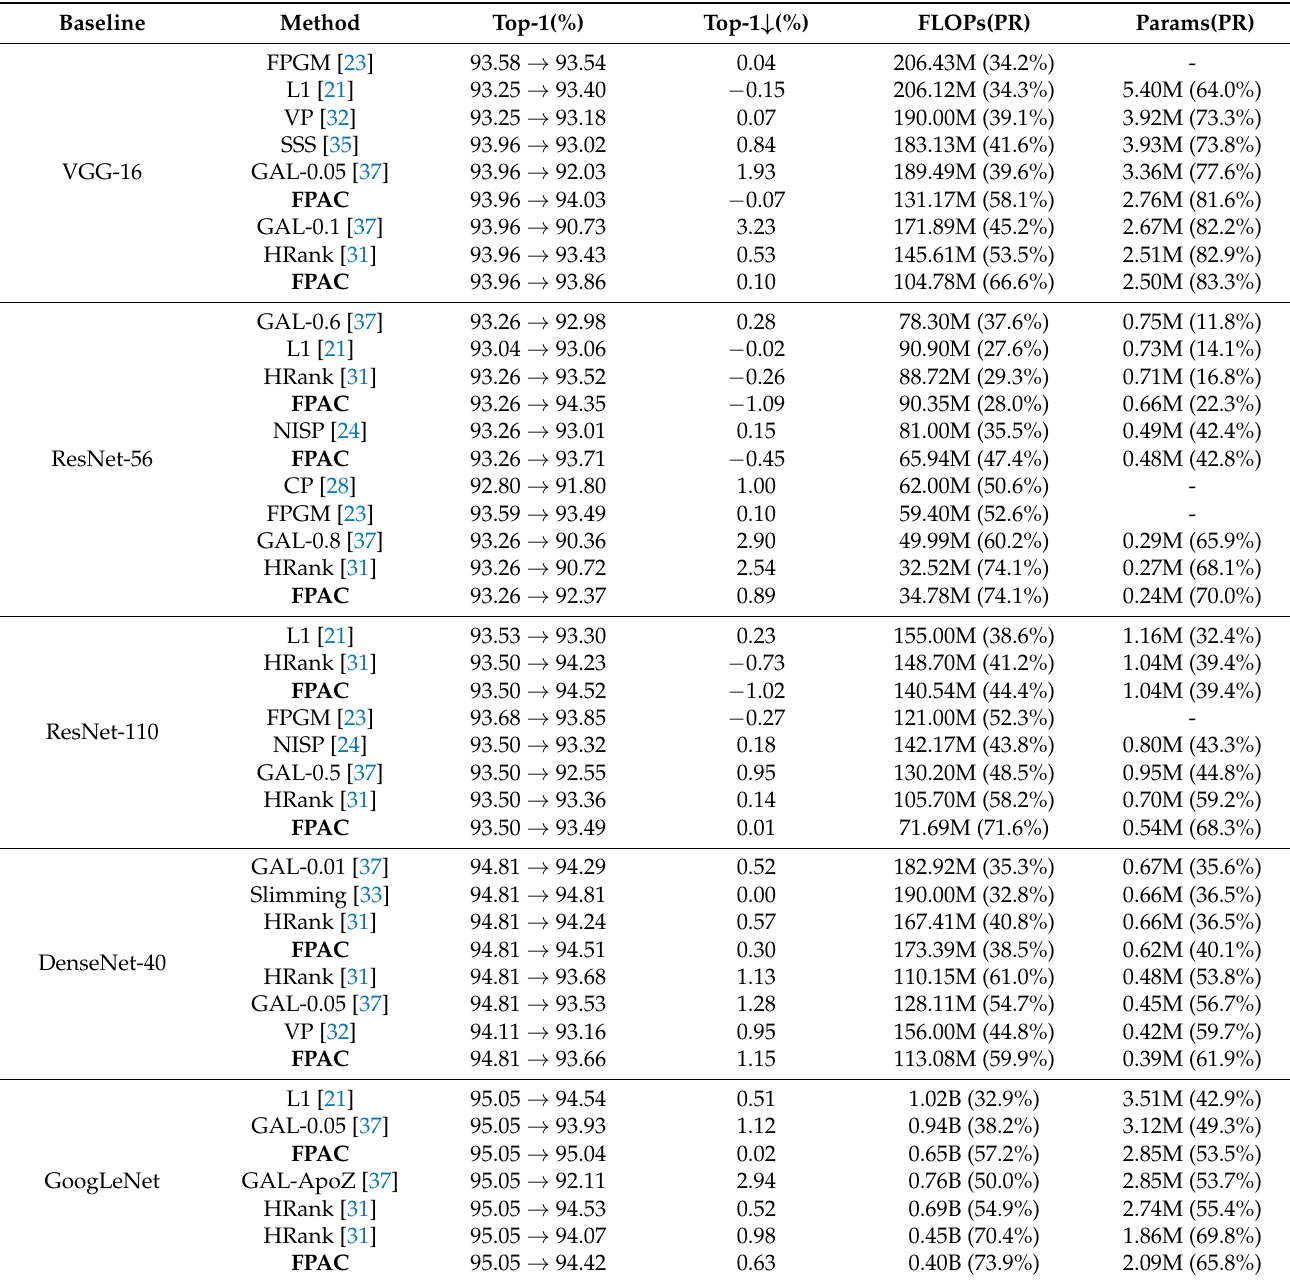
Table 1. Pruning results on CIFAR-10. “Top-1”: accuracy. “Top-1 ↓ ”: decrease in accuracy, smaller is better. A negative value here indicates an improved model accuracy. “FLOPs(PR)”: FLOPs(pruning ra- tio). “Params(PR).”: parameters(pruning ratio). “-”: results not reported in the corresponding